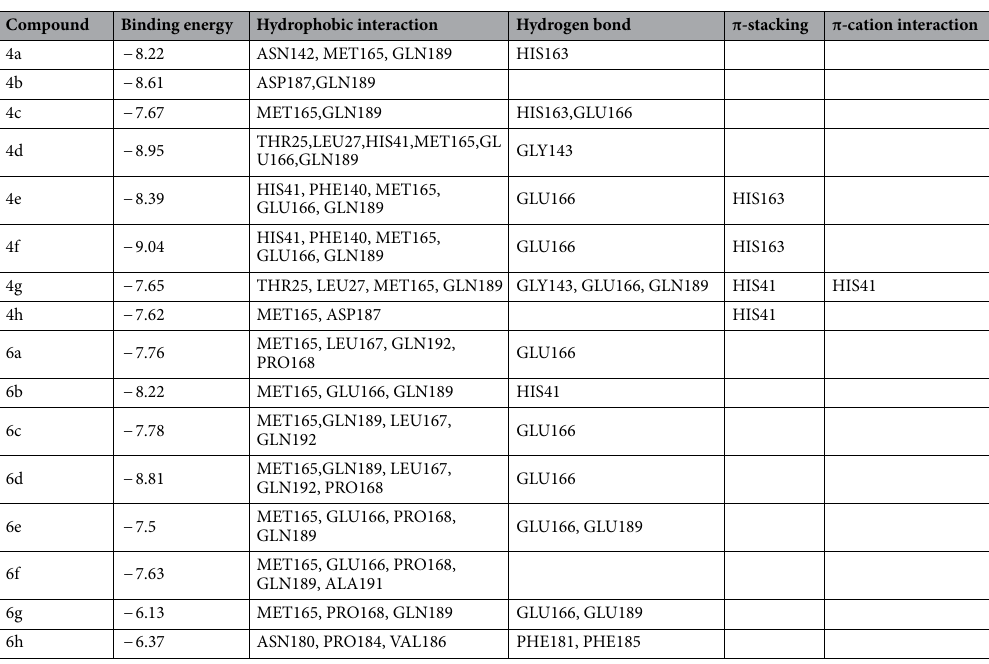
Table 8. The binding affinity of compounds 4a–h and 6a–h with Mpro-Sars-Cov2 (PDB: